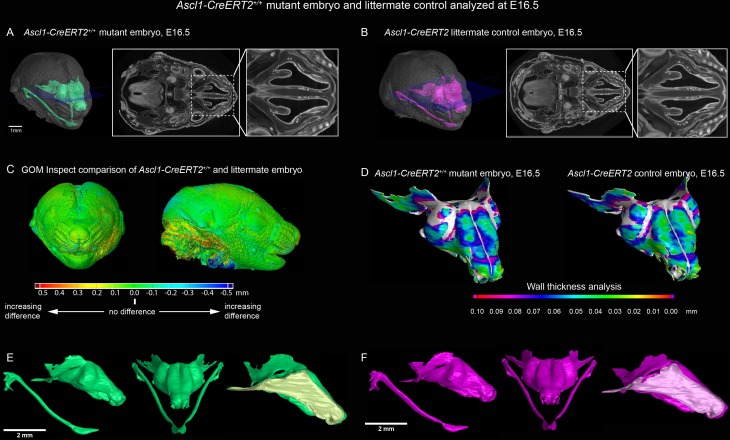
Ascl1 knockout embryo analyzed at E16.5 does not show any significant changes in formed nasal capsule.(A) Ascl1 knockout embryo with segmented nasal capsule and (B) littermate control. (C) GOM Inspect software analysis and shape comparison between mutant and control embryos. (D) Wall-thickness analysis of mutant (left) and control (right) embryos shows no significant changes. (E–F) Segmented nasal capsules of mutant (left, green) and control (right, magenta) embryos.